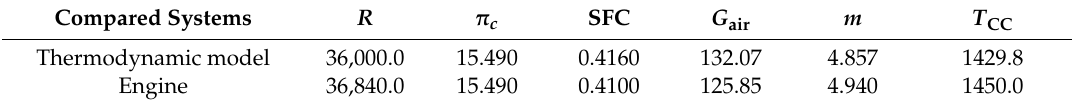
Table 3. Simulated and real engine